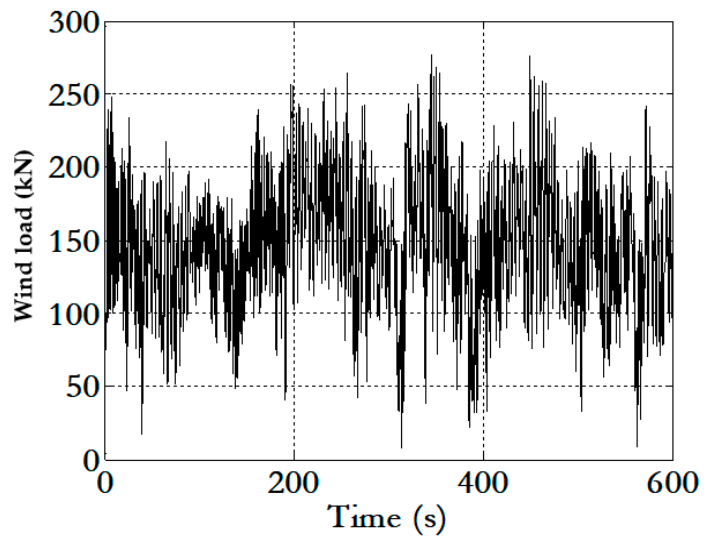
Figure 2. Illustration of wind load at hub level.